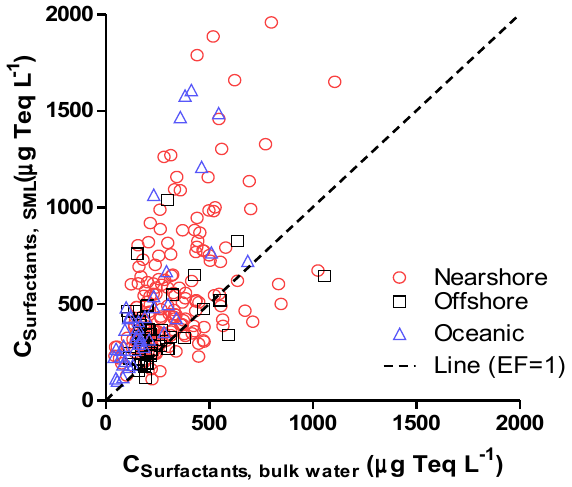
Fig. 4. SML concentration versus bulk water concentrations of surfactants in nearshore (within 2km from coast), (2–20km from coast) and open ocean (further than 20km off the coast). Bro- ken line indicates equal concentrations in SML and bulk water (i.e. EF = 1).